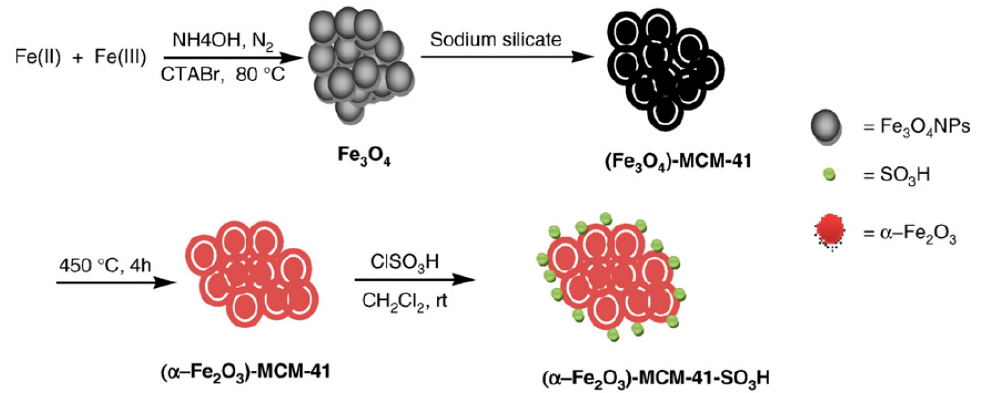
Figure 57. Preparation of ( α -Fe 2 O 3 )-MCM-41-SO 3 H. Reproduced with permission from [153].